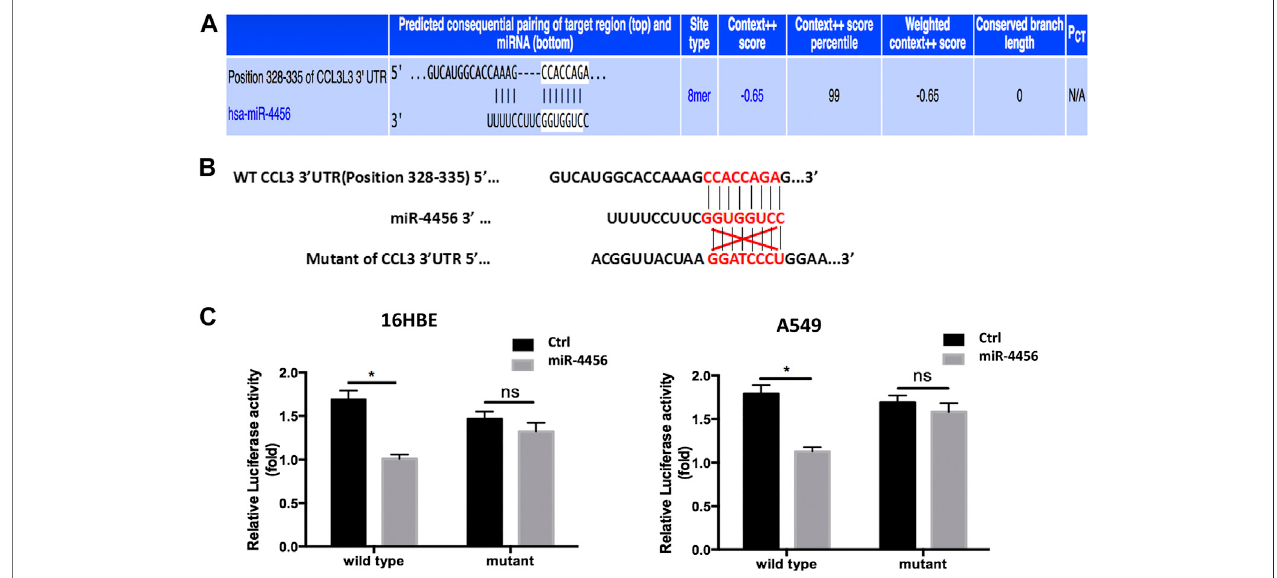
FIGURE 4 | miR-4456suppressesCCL3expressionthrough3 ʹ UTRofCCL3 (A,B) Thepredictedduplexformationbetweenwildhumantype(WT)CCL33 ʹ -UTRandhuman miR-4456 (C) luciferase assays were performed to detect the regulation of miR-4456 on WT and mutant CCL3-3 ʹ UTR. Assays were performed on CCL3-wt.3 ʹ UTR ± miR-4456,